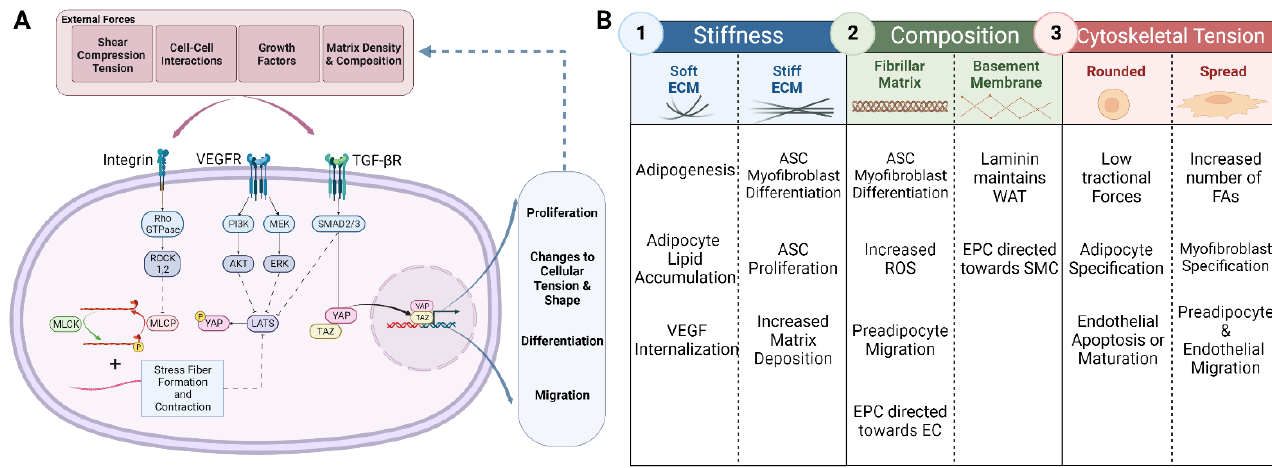
Figure 3. Schematic representations of ( A ) major mechanotransduction pathways and their down- stream effects ( B ). Mechanoresponses of adipose derived stem cells (ASC), adipocytes, endothelial progenitor cells (EPC), and endothelial cells (EC) in situations of (1) altered matrix stiffness, (2) altered matrix composition, and (3) altered internal forces. Abbreviations: Vascular endothelial growth fac- tor (VEGF) receptor (VEGFR), transforming growth factor- β receptor (TGF- β R), Extracellular matrix (ECM), Ras homologous GTPase (Rho GTPase), Rho-associated protein kinase (ROCK), myosin light chain phosphatase (MLCP), myosin light chain kinase (MLCK), phosphatidylinositol 3- kinase (PI3K), protein kinase B (Akt), mitogen-activated protein kinase kinase (MEK), extracellular-signal- regulated kinase (ERK), large tumor suppressor (LATS), small mothers against decapentaplegic (SMAD), yes-associated protein (YAP), transcriptional coactivator with PDZ-binding motif (TAZ), reactive oxygen species (ROS), white adipose tissue (WAT), smooth muscle cell (SMC), and focal adhesion (FA). Created with Biorender.com.